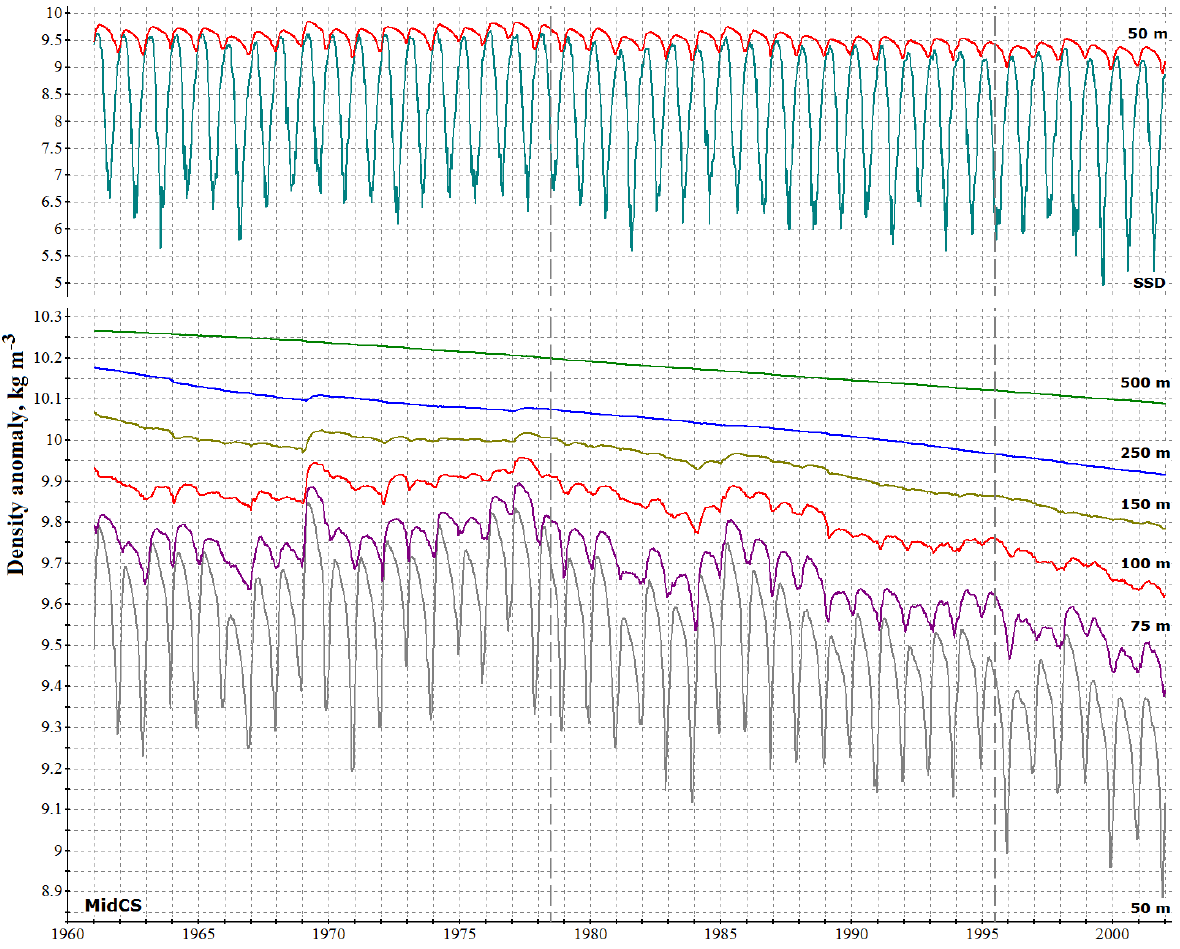
Figure 11. Evolution of a density anomaly (kgm − 3 ) at different depths (SSD – sea surface density) averaged over the MidCS